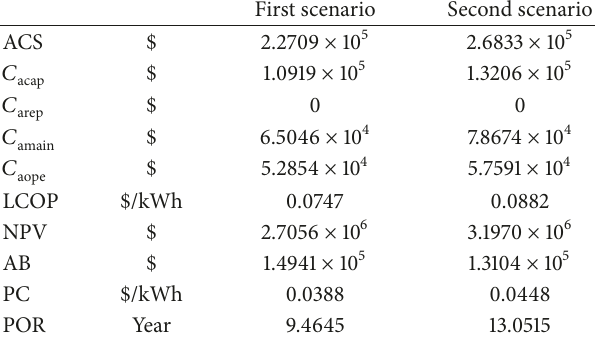
Table 8: Economic